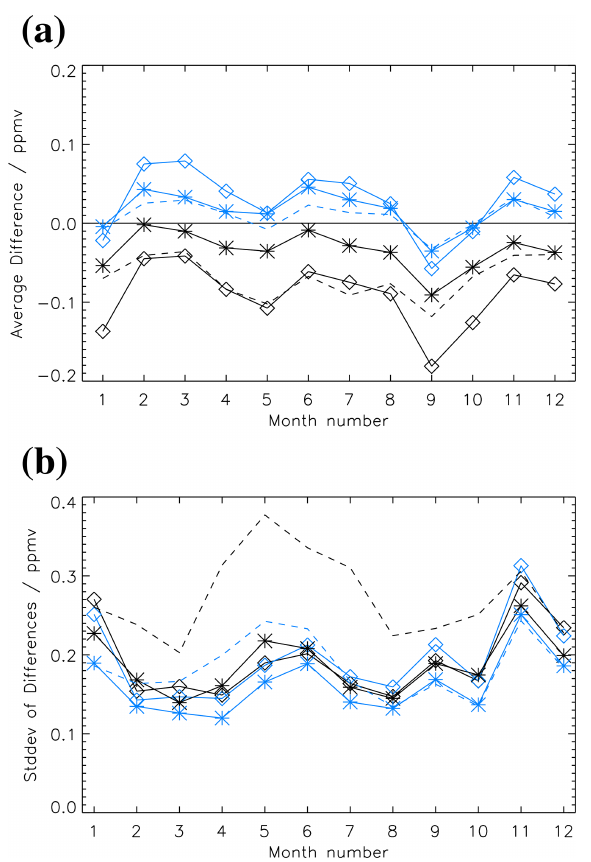
Figure 7. (a) Monthly mean differences between RR and FR ozone data. (b) Standard deviation of these differences. Differences and standard deviations are averaged over all latitudes and over altitude ranges of 20–50km (solid lines with diamonds), 0–70km (solid lines with asterisk), and 0–80km (broken lines). Version 5 data are shown with black and version 8 data with blue curves. See text for more details.